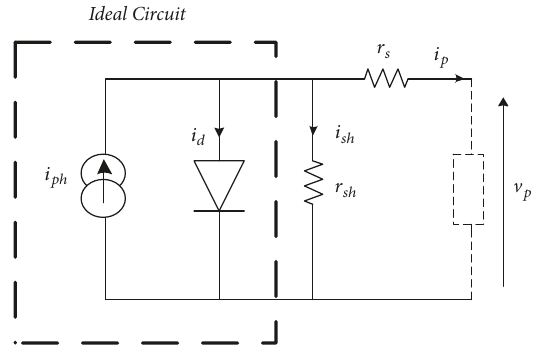
Figure 1: Equivalent circuit of real solar